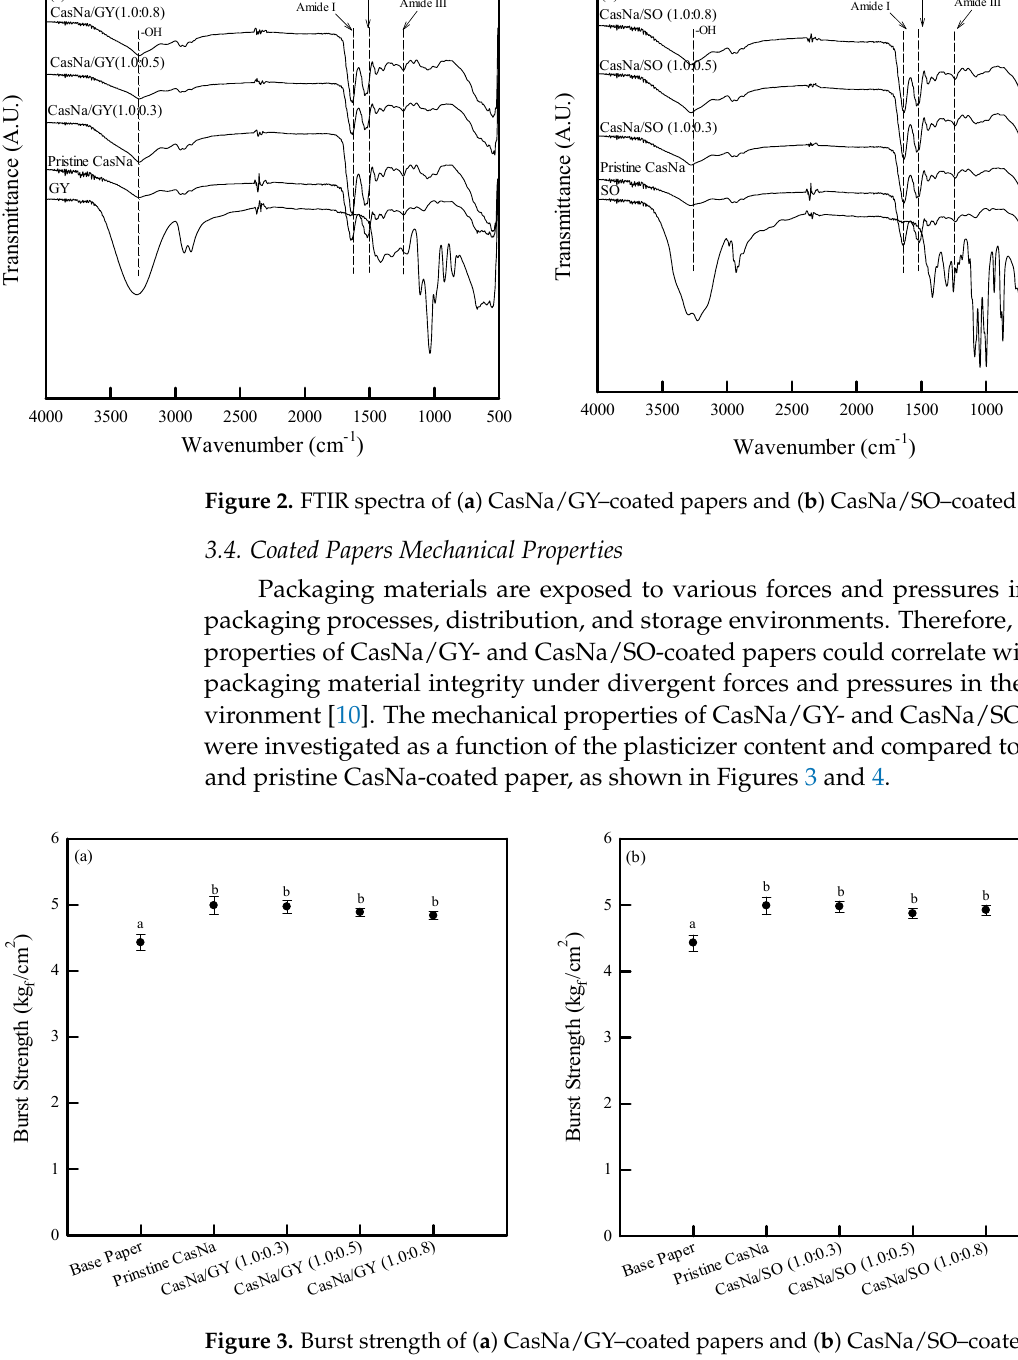
Figure 3. Burst strength of ( a ) CasNa/GY–coated papers and ( b ) CasNa/SO–coated papers. Lower- case letters (a–b) indicate statistically significant differences ( p < 0.05).